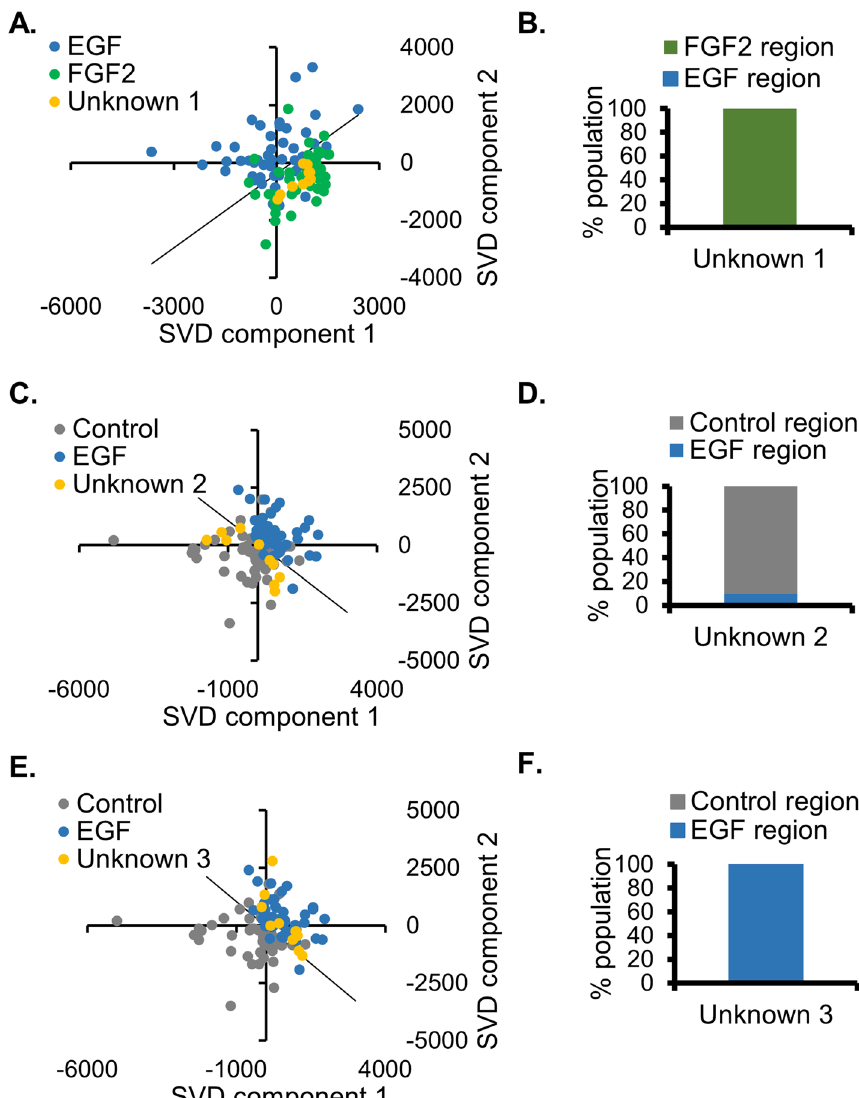
Fig. 6 Unknown organoids identified using SVD analysis of Raman spectra. Raman spectra derived from the unknown (blinded) datasets of cell-dense organoid regions were subjected to SVD analysis with known FGF2 (green), EGF (blue), and control (gray) datasets (derived from Fig. 3). One representative plot is shown for each unknown, which demonstrates codistribution with a known treatment. A SVD plot of unknown 1 with known EGF and FGF2 spectra. B Percentage of population of unknown 1 codistributed with FGF2 or EGF. C SVD plot of unknown 2 with known EGF and control spectra. D Percentage of population of unknown 2 codistributed with EGF or control. E SVD plot of unknown 3 with known EGF and control spectra. F Percentage of population of unknown 2 codistributed with EGF or control (specific assignments of unknown samples detailed in Table 2). Additional SVD comparisons for unknowns 1–3 are provided in Additional file